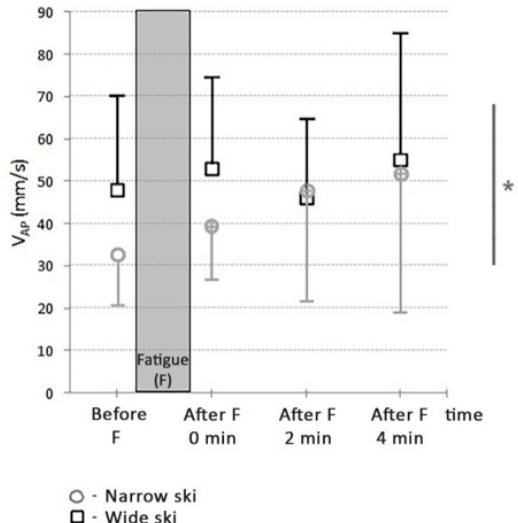
Figure 5. Center of pressure (CoP) velocity in anteroposterior direction (V AP ) in a prefatigued state (before F) and at different times after fatigue (after F) with two different ski waist-widths. + depicts statistically significant difference compared to prefatigued state ( p < 0.05); * depicts statistically significant difference between all-narrow against all-wide waist-width measurements.